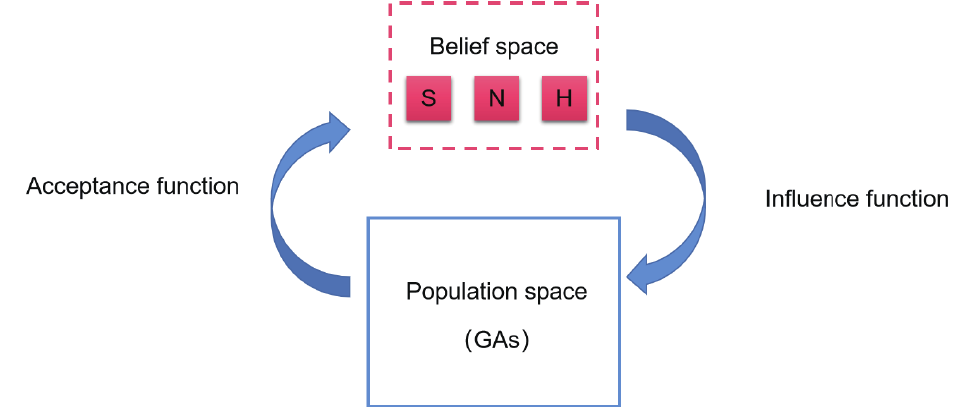
Figure 3. Framework of